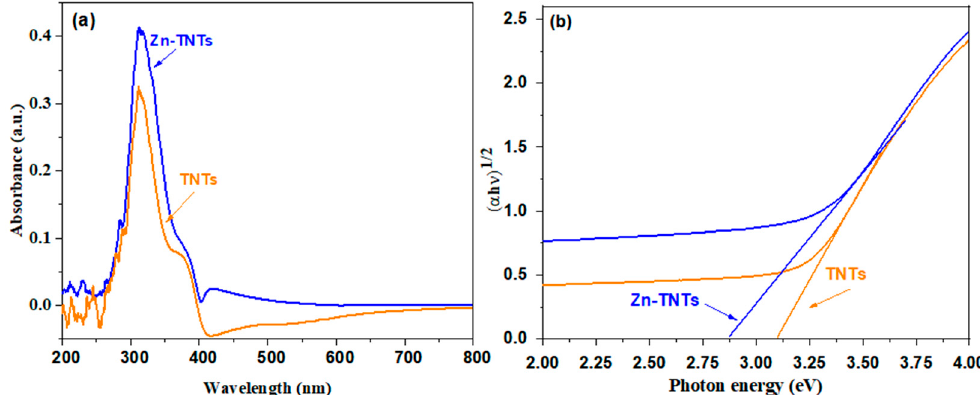
Figure 2. ( a ) UV-vis spectra and ( b ) Tauc’s grphs of undoped TNTs and Zn-doped TNTs